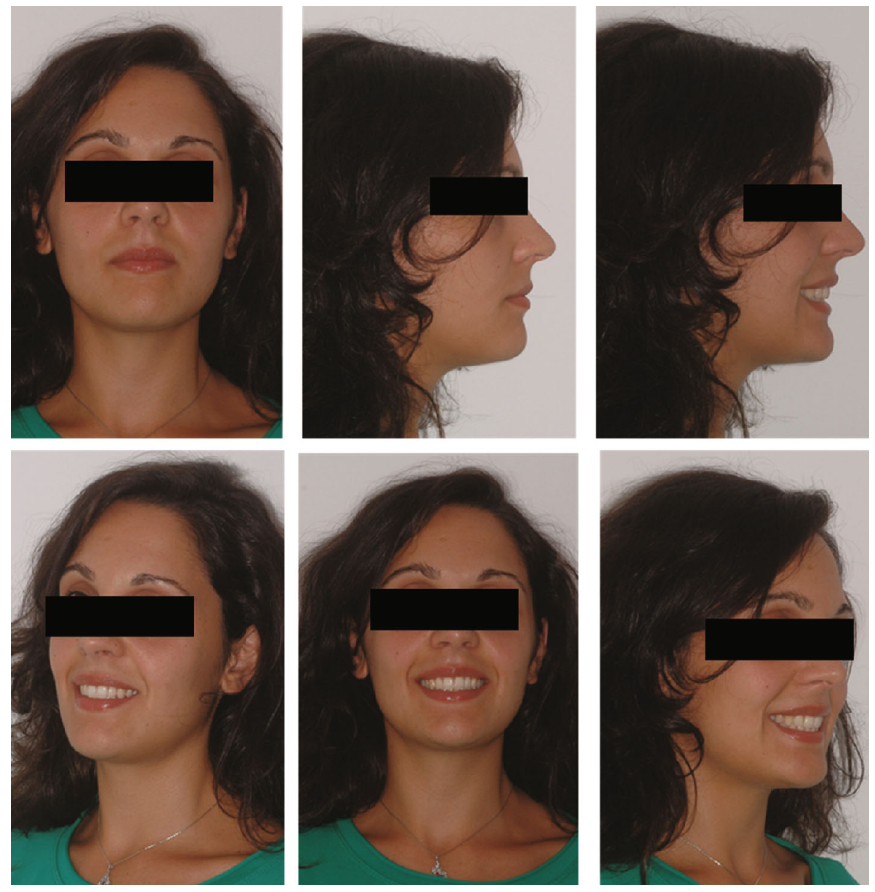
Figure 19: 14-year follow-up extraoral